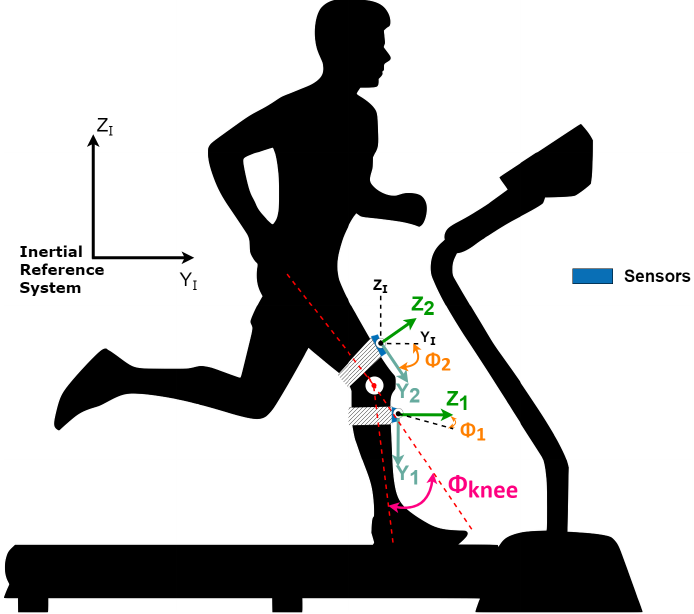
Figure 6. Sensors with the angles representation. Adapted from